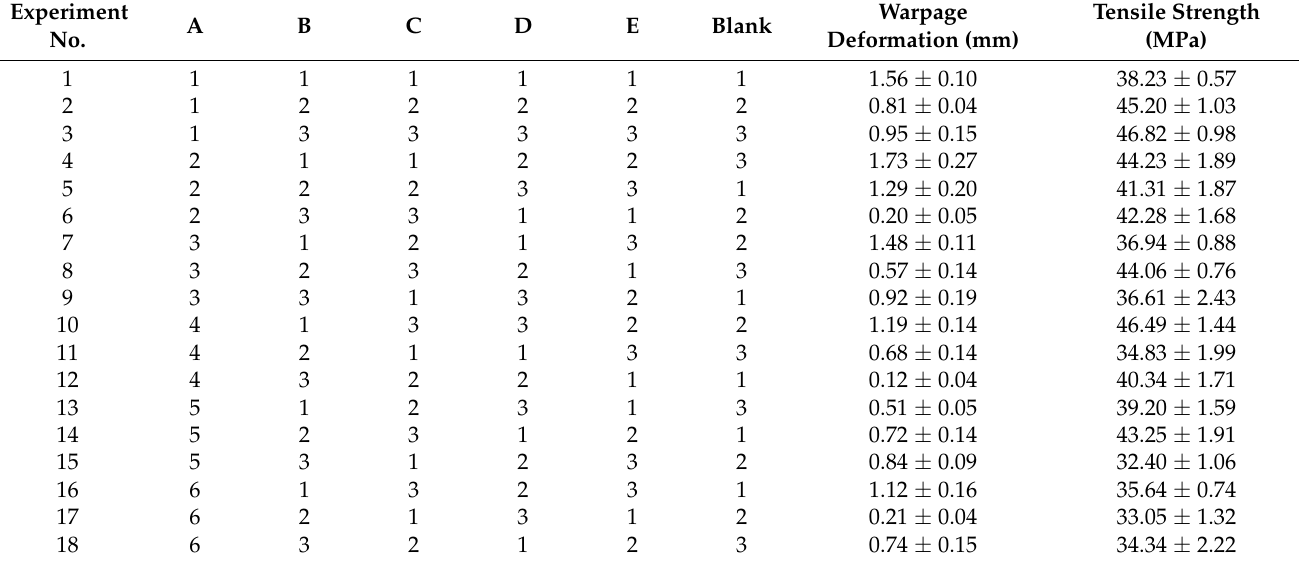
Table 4. Results of the Orthogonal